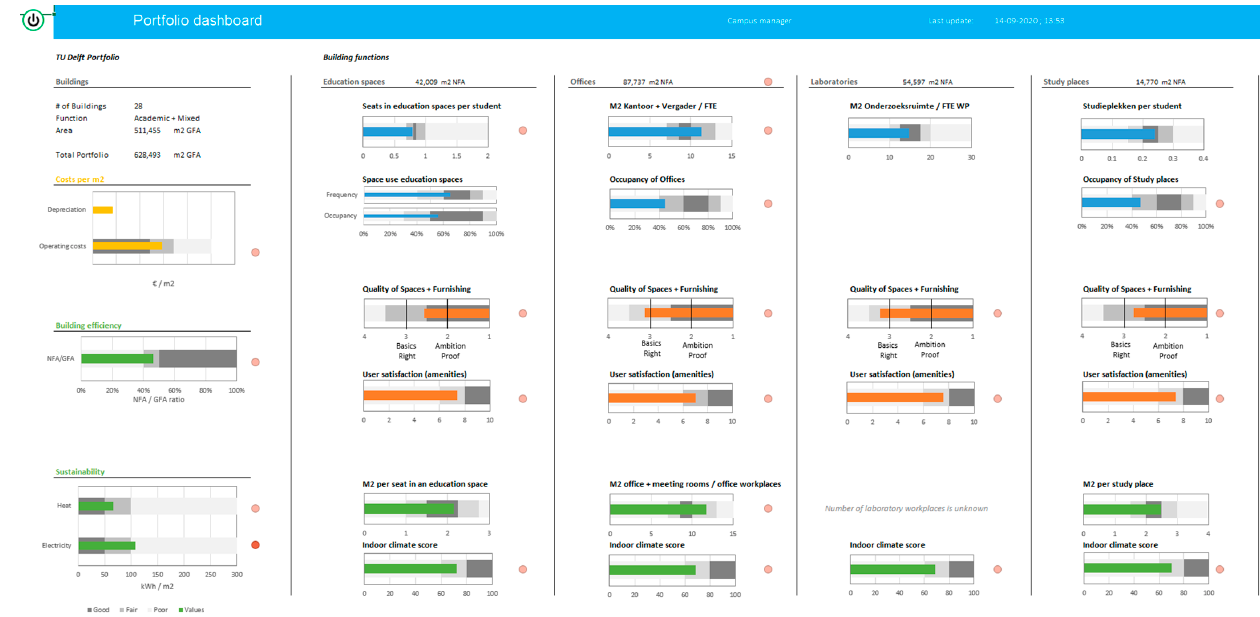
Figure 7. Main dashboard ‘Portfolio TUD’ (tested in workshop